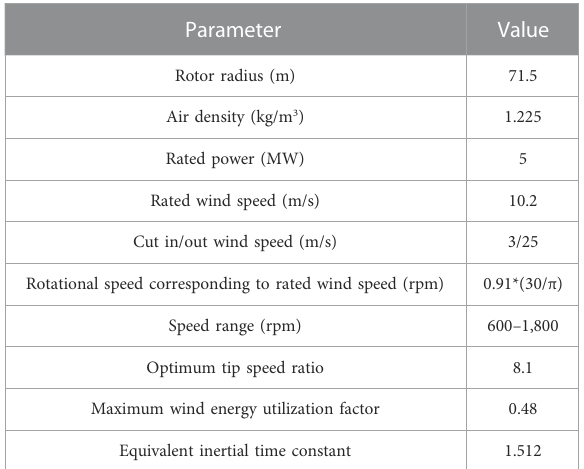
TABLE 1 Parameters of wind